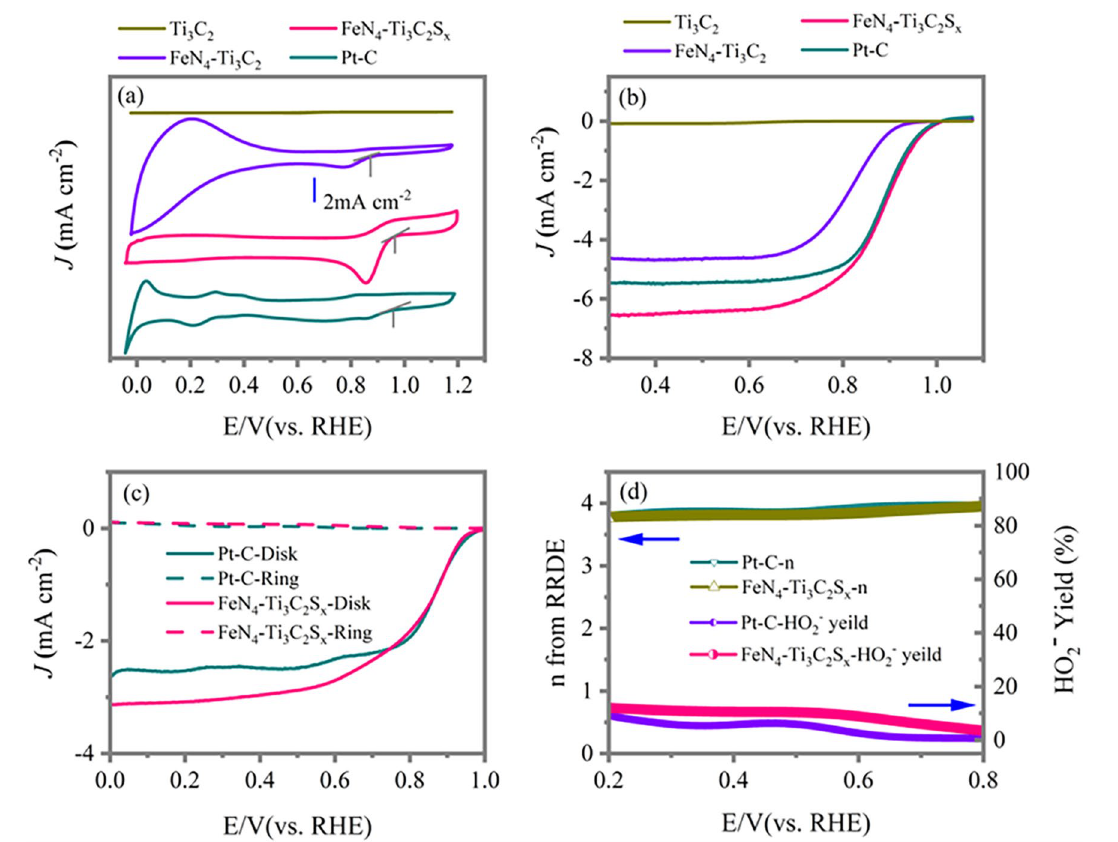
Fig. 3 a CV curves of pristine Ti 3 C 2 , FeN 4 –Ti 3 C 2 , FeN 4 –Ti 3 C 2 S x , and commercial Pt–C recorded at 100 mV s −1 in O 2 saturated 0.1 M KOH solution. b LSV curves of pristine Ti 3 C 2 , FeN 4 –Ti 3 C 2 , FeN 4 –Ti 3 C 2 S x , and commercial Pt–C at 1600 rpm rotation speeds. c RRDE measurements of samples